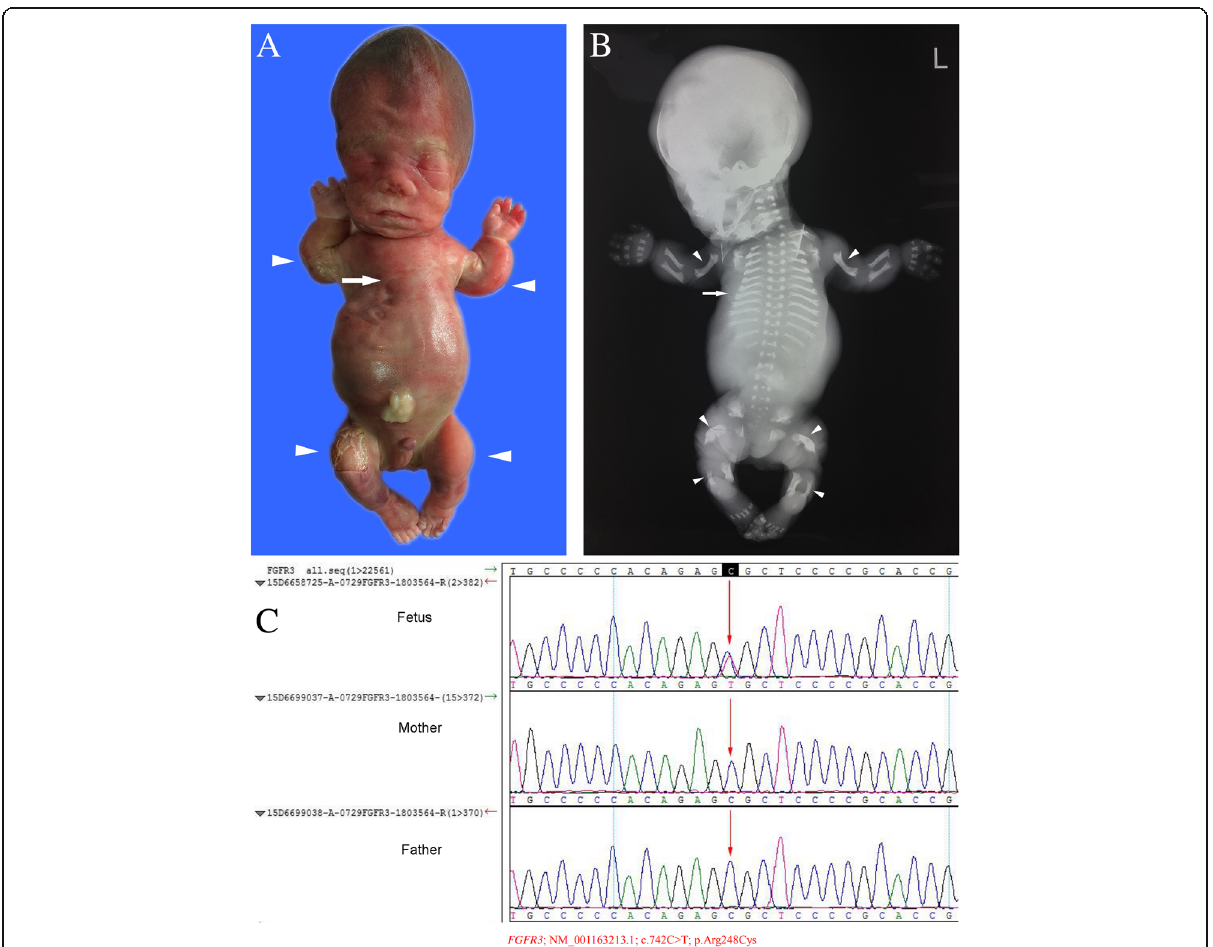
Fig. 4 Case 26: The fetus with fatal achondroplasia and fibroblast growth factor receptor 3 (FGFR3) gene mutations. a Gross anatomy of the aborted fetus, showing the markedly short arms and legs (arrowheads), with a narrow chest (arrow). b X-ray images of the aborted fetus, showing the “ telephone receiver ” appearance of the femurs and humeri, the malformation of the metaphyseal (crateriform) (arrowheads), and the narrow thorax (arrow). c The fetus carried the c.742C > T (p.Arg248Cys) mutation in the FGFR3 gene. The Sanger verification revealed that